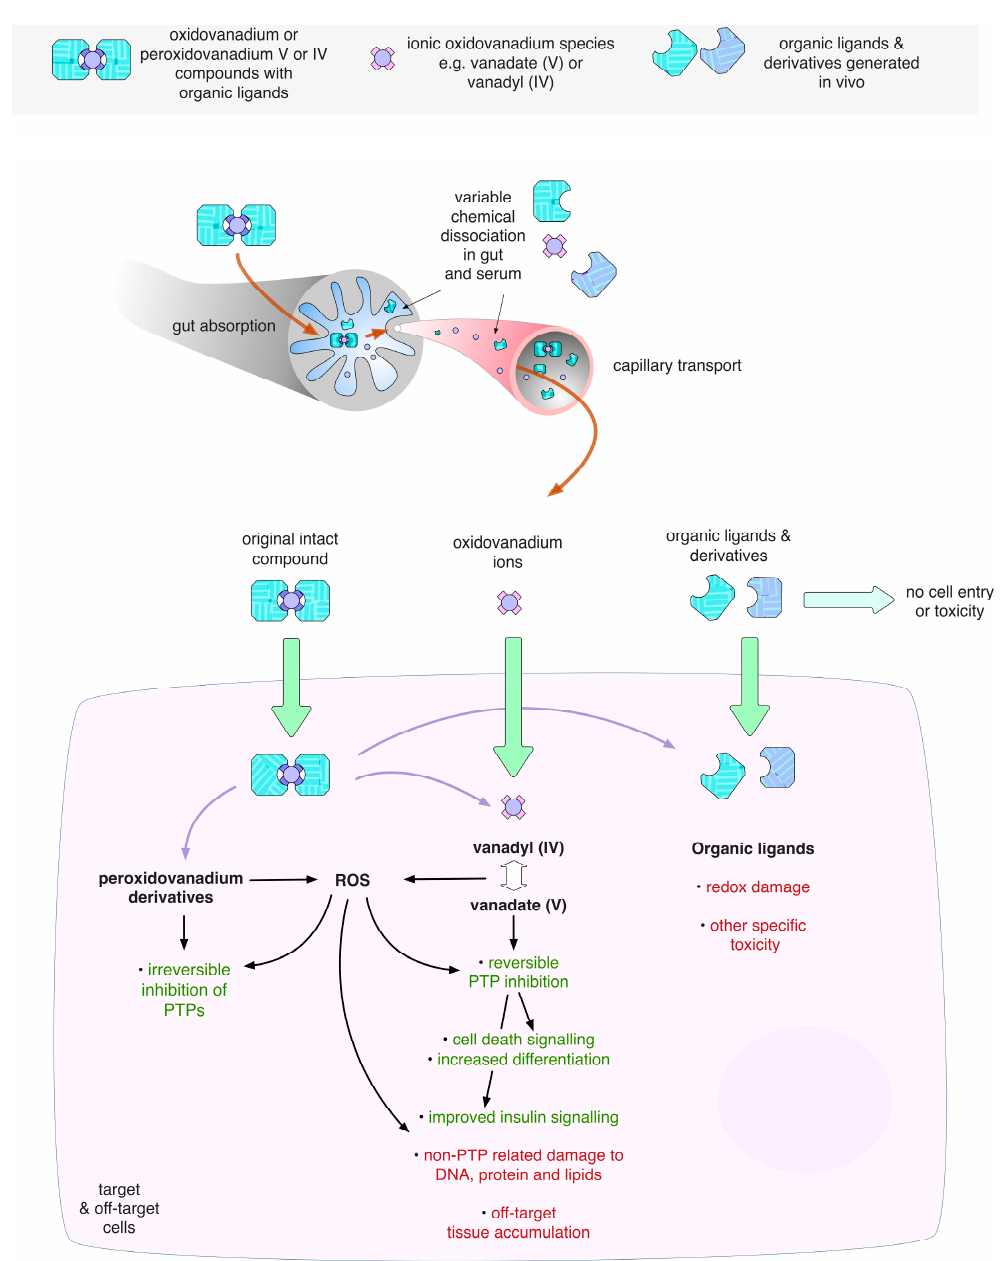
Figure 3. Schematic of the ingestion, chemical dissociation and cellular targeting of a generic oxidovanadium complex. Complexes of oxidovanadium with organic ligands can have good bioavailability across the gut wall, but can dissociate rapidly in the gut and blood into constituent vanadate ions and ligand derivatives. At target cells the ligands may or may not enter cells, but intracellularly they can have significant cytotoxic effects. Similarly, vanadate will enter cells and have a range of effects including PTP inhibition. Some compounds may be very stable in the blood and these may enter cells intact, where they are thought to ultimately dissociate. Oxidovanadium and peroxidovanadium compounds can generate ROS in cells indirectly or directly, respectively. Such ROS can in turn inhibit PTPs, or cause non-specific cell damage. Note that the cell shown could also represent an off-target site where these chemicals have detrimental actions. It may therefore be true that no matter what the nature of the original vanadium complex, it may be the derived, uncomplexed vanadate that is the active PTP inhibitor. Nevertheless, the continued